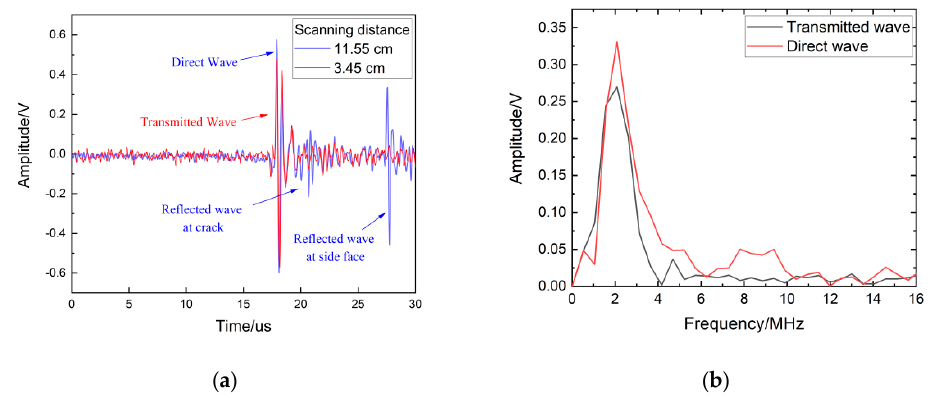
Figure 11. Experimental signals: ( a ) time domain; ( b ) frequency domain.